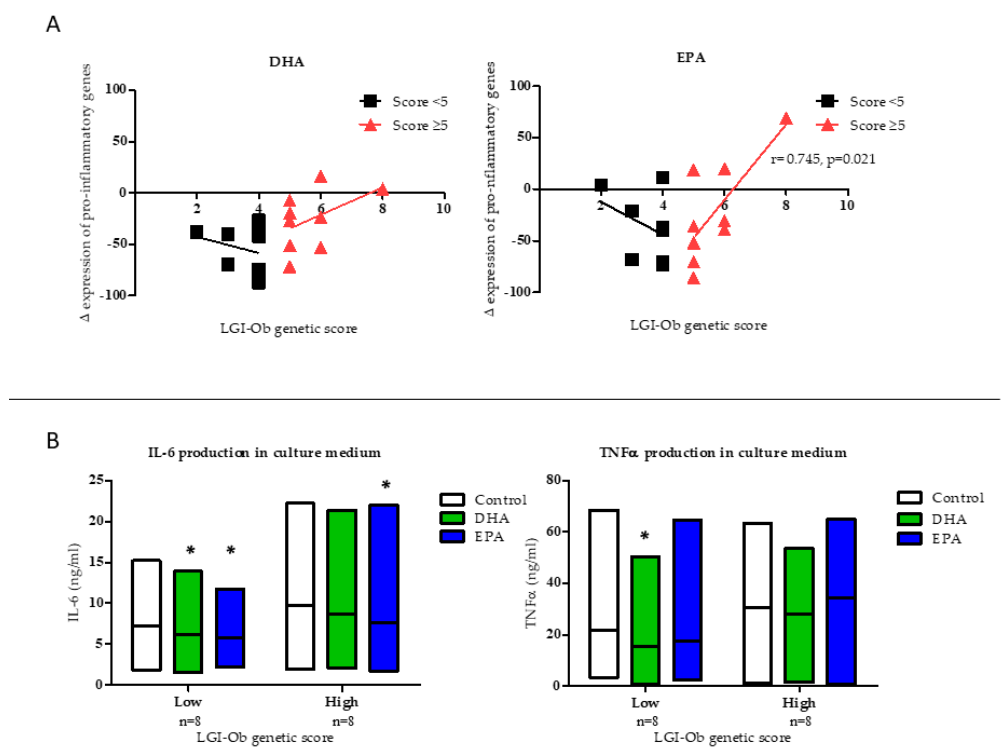
Figure 2. Effects of Docosahexaenoic Acid (DHA, 10 µ M) and Eicosapentaenoic Acid (EPA, 10 µ M) on ( A ) overall response in the expression of pro-inflammatory genes ( ∆ EPG), in PBMC measured by Reverse Transcription quantitative Polymerase Chain Reaction (RT-qPCR), and represented according to the LGI-Ob genetic score of the individuals. Cells were incubated for 48h with DHA and EPA and the effects in each individual were calculated in comparison with the respective untreated control cells. Pearson correlations were used to assess linear association between LGI-Ob genetic score and ∆ EPG; ( B ) IL-6 and TNF α production in PBMC culture media by LGI-Ob genetic score: Low (<5) or high ( ≥ 5). Two-way repeated measures ANOVA was performed to compare differential cytokine production from control cells vs EPA or DHA treated cells in both LGI-Ob genetic score groups (* p < 0.05). Boxes represent the dispersion (maximum and minimum) and the horizontal line represents the arithmetic mean in each treatment. Data correspond to subjects from NUTRI-BLOOD study ( n =